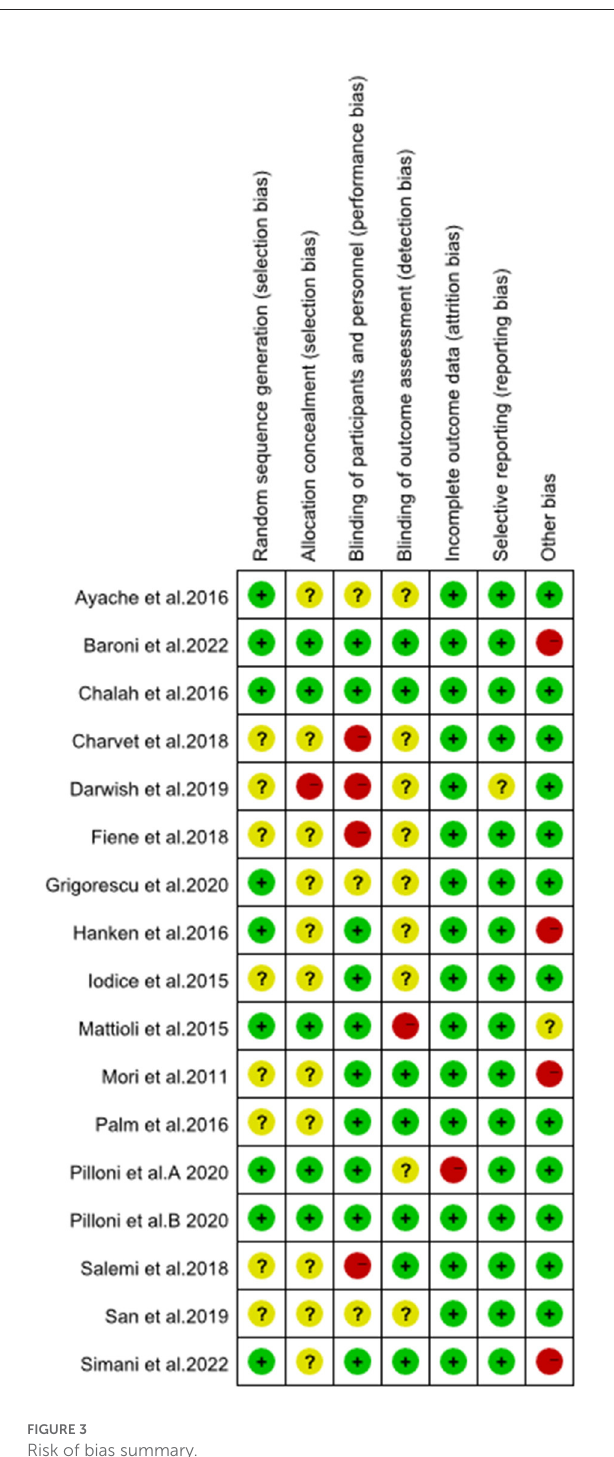
FIGURE3 Risk of bias summary.